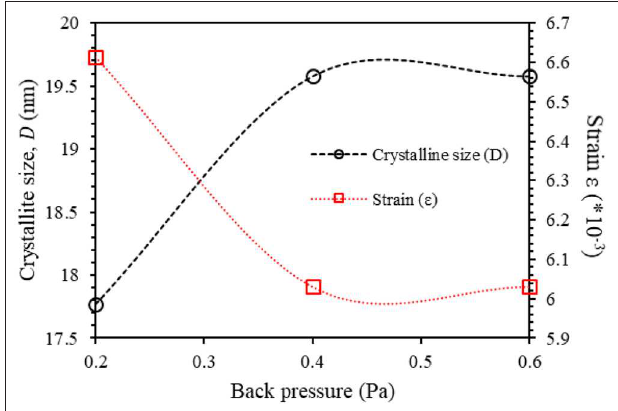
Frontiers in Physics |